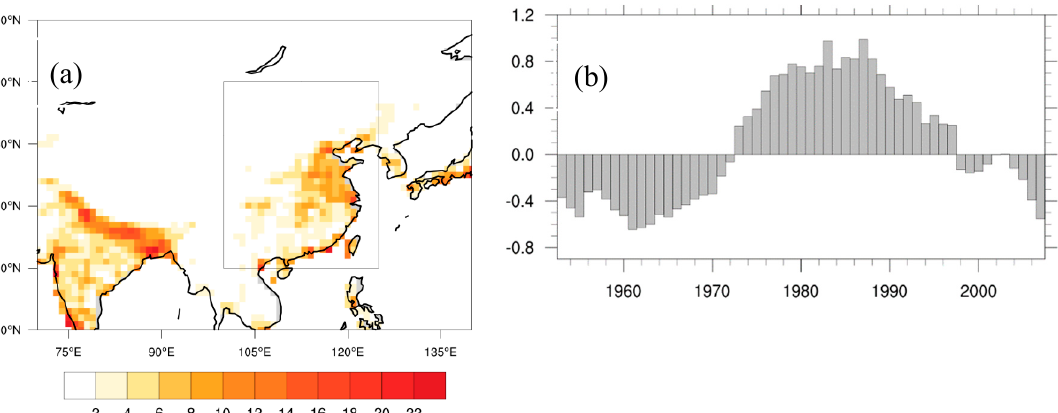
Figure 1. ( a ) Percentage distribution of urban land-cover fraction in control runs of CAM5.1 model (unit: %). The black rectangle shows the major urban agglomeration over eastern China. The urban land cover were removed in experiments of NoU_P and NoU_N; ( b ) The meta data of PDO index derived as the leading principle component (PC) of monthly SST [14] anomalies in the North Pacific Ocean, poleward of 20 ◦ N. The monthly mean global average SST anomalies were removed to separate this pattern of variability from any “global warming” signal that may be present in the data. Here shows the JJA (June, July, and August) average which is the result of 15-year running